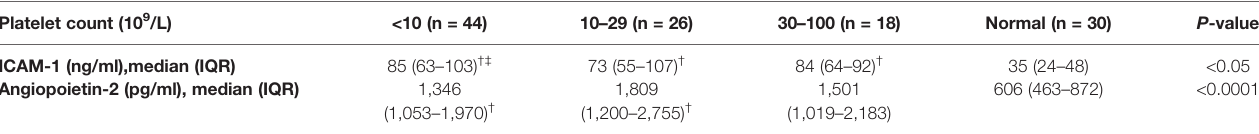
TABLE 2 | Angiopoietin-2 and ICAM-1 concentrations in corticosteroid resistant ITP patients strati fi ed by platelet count at enrollment. Platelet count (10 9